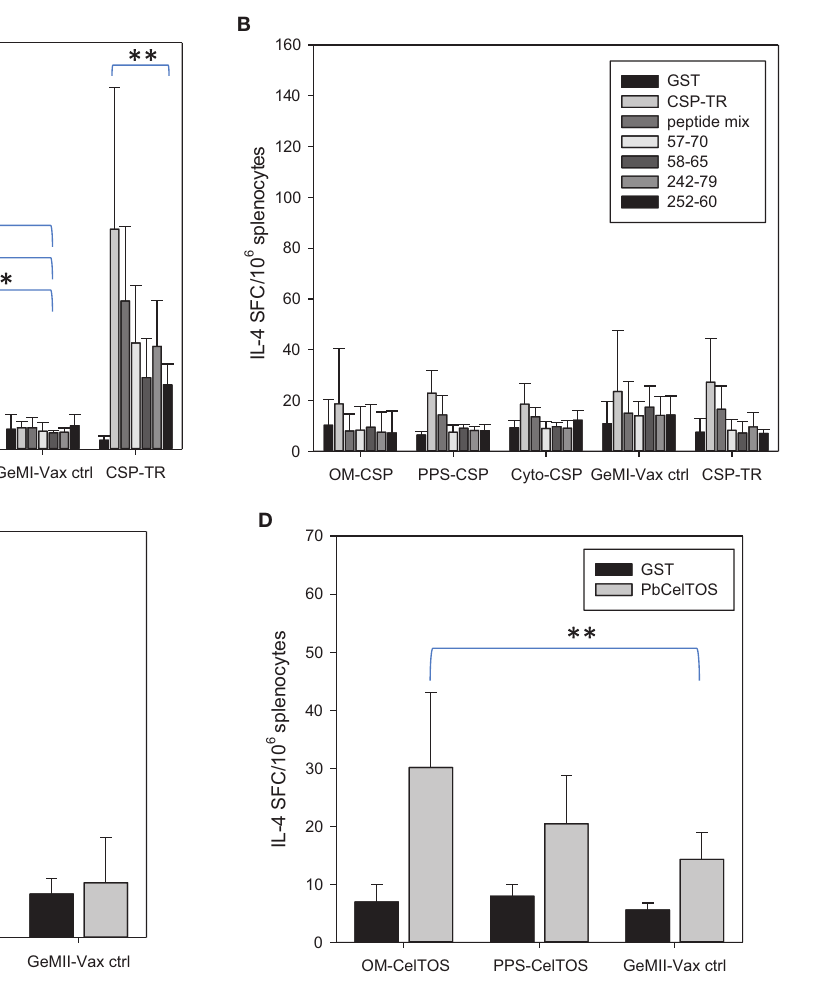
I-A d restricted CD4 + epitopes, peptides CS 58-65 and CS 252-60 represents H2K d -restricted CD8 + epitopes). GST = negative control. (C,D) Splenocytes stimulated ex vivo with either recombinant Pb CelTOS or GST protein (30 µ g/mL). Data are expressed as the mean and standard error of the mean (SEM) number of spot-forming cells (SFC) from n = 5 mice/group. Asterisk indicates statistical significance (Students T -test): * p < 0.05, ** p <